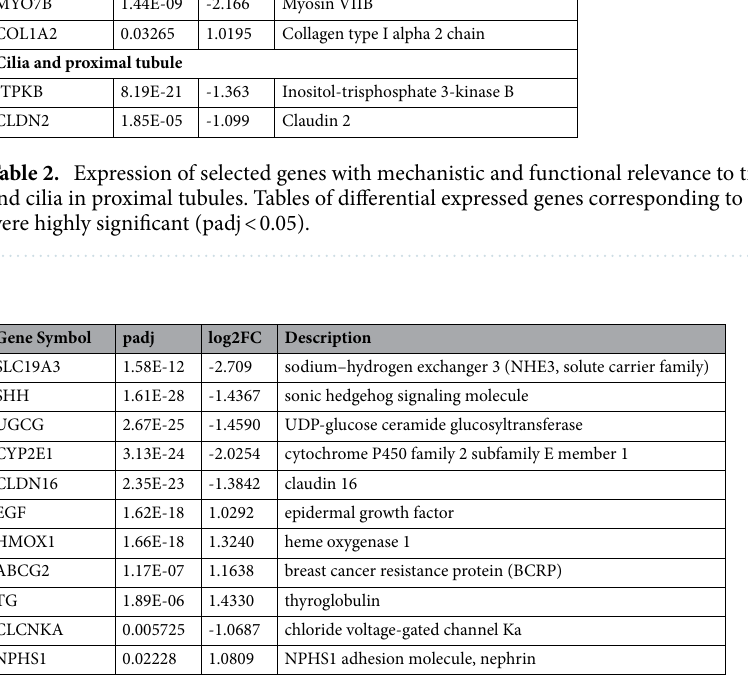
Table 3. Expression of selected genes with relevance to the process of endocytosis in proximal tubules. Tables of differential expressed genes corresponding to morphological terms that were highly significant (padj < 0.05).